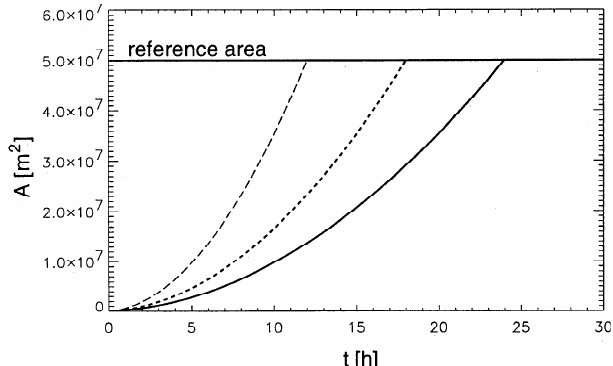
Fig. 4. Evolution of the plume cross-section A p showing the plume lifetime t p = t ref that corresponds to the intersecton with the ref- erence area A ref . Solid line: t ref = 24h; dashed line: t ref = 18h; long-dashed line: t ref = 12h. Reprinted from Petry et al. (1998). An edited version of this paper was published by AGU. Copyright (1998) American Geophysical